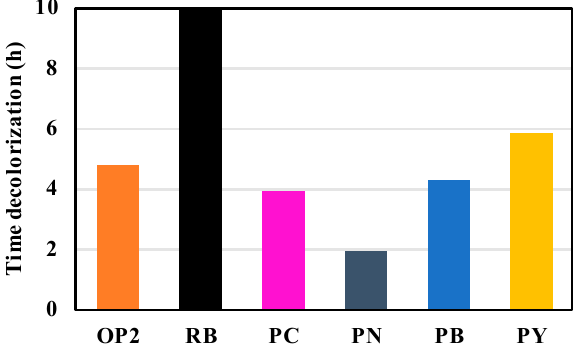
Figure 6. Time of decolorization of each dye.